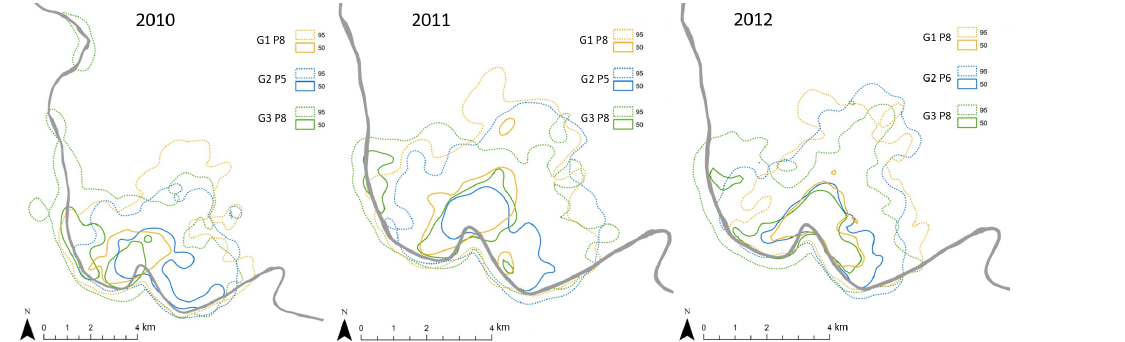
Figure 7. Position, extent, and overlap of annual home ranges (95%) and core areas (50%) of Guinea baboon gangs (G) and parties (P). The grey line depicts the Gambia River. Note that the scales vary slightly among years.